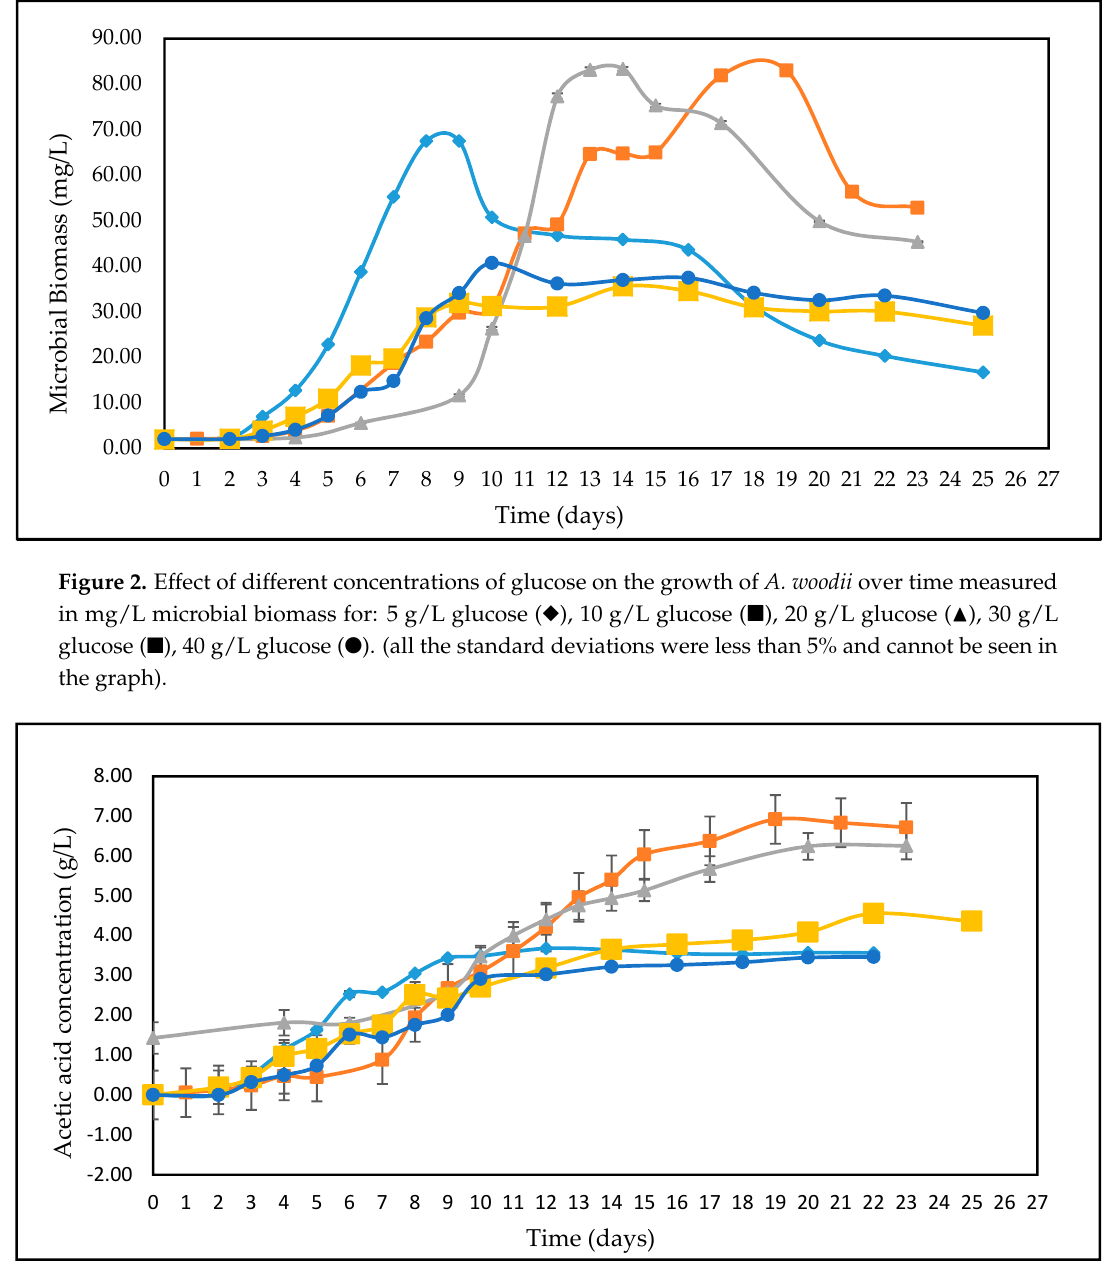
Figure 3. Effect of different concentrations of glucose on acetic acid production by A. woodii over time measured in g/L acetic acid produced for: 5 g/L glucose ( (cid:117) ), 10 g/L glucose ( (cid:4) ), 20 g/L glucose ( (cid:78) ), 30 g/L glucose ( (cid:110) ), 40 g/L glucose ( (cid:108) ). (all the standard deviations were less than 10%).